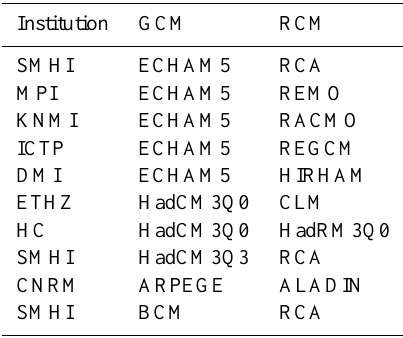
Table 1. List of the employed climate model chains from the ENSEMBLES